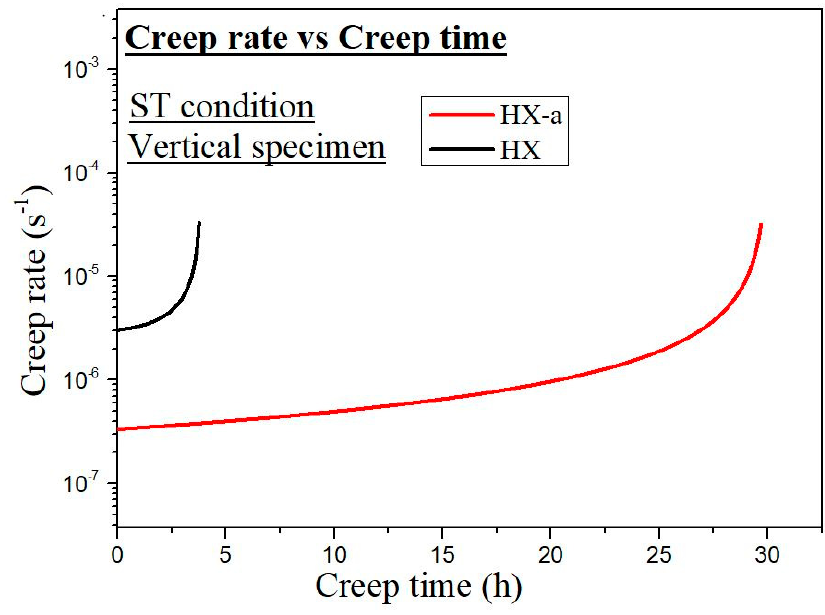
Figure 13. Creep rate vs. creep time curves of ST vertical specimens.